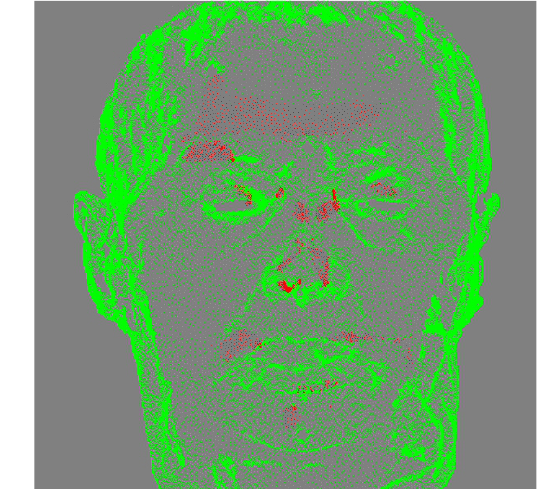
Figure 11. Fitting residuals.